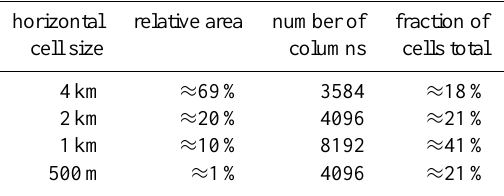
Table 3. Synopsis of spatial structure for academic test case.